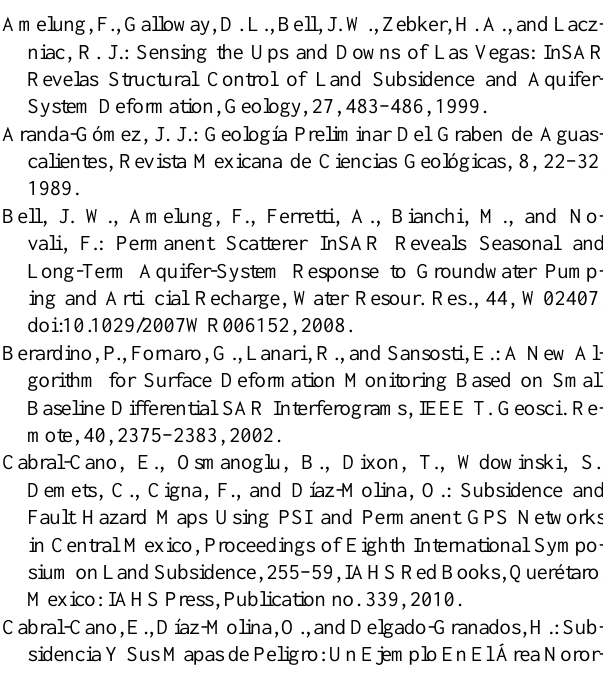
level 3 plus a geophysical study to find out incipient ground failure.